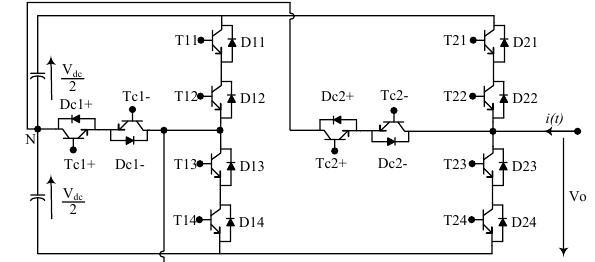
Fig. 1 HB-NPP five level topology.